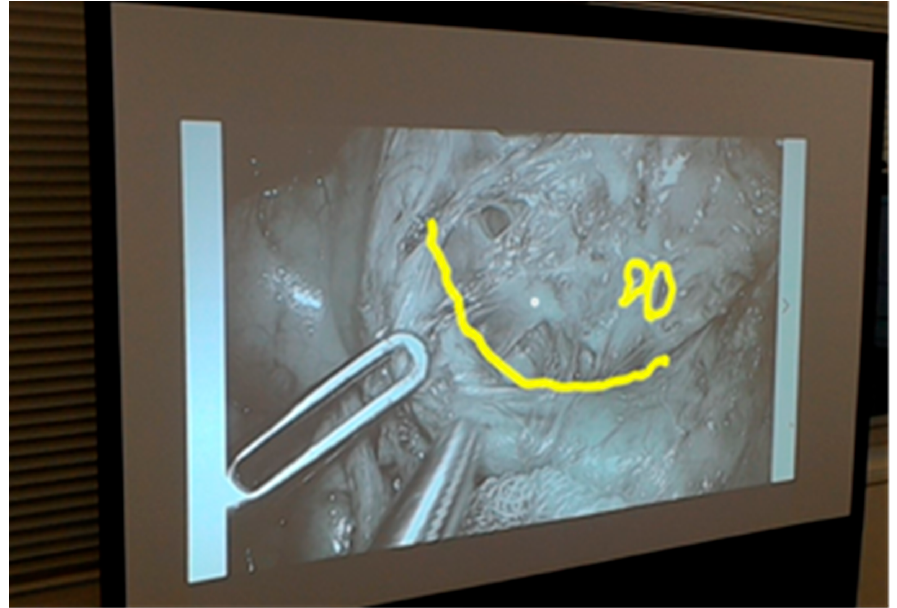
Figure 2. Using ARHD to draw instructions on the surface of a projected endoscope image. Note that the overlapped image can only be viewed through AR glasses and the endoscope image is actually designed to be output to HD monitors. The image shown in this figure is projected output to the non-surgical personnel in the operating room to confirm what kind of image the surgeons are gazing